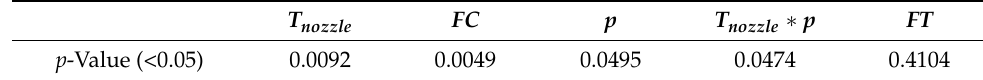
Table 2. p -values of various test parameters for tensile strength.